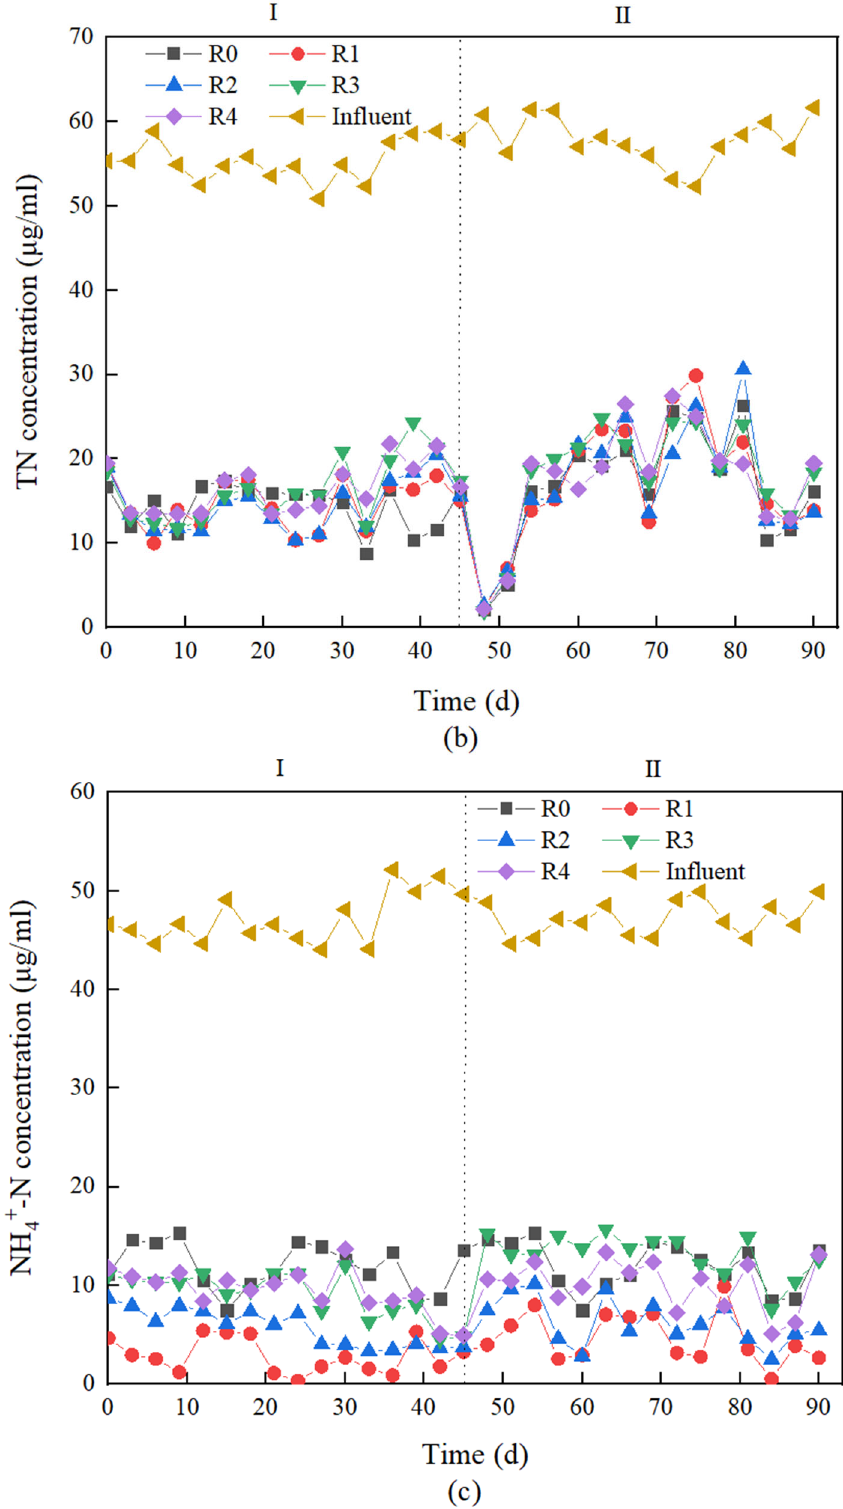
Figure 2. ( a ) Removal performance of chemical oxygen demand (COD). ( b ) Removal performance of total nitrogen (TN). ( c ) Removal performance of ammonia nitrogen (NH 4+ ‑N). The comparison of stage I and stage II data showed that the four antibiotic‑stressed re‑ actors did not differ significantly in COD removal, and antibiotics did not have a significant effect on COD removal capacity ( p > 0.05), probably due to the presence of antibiotic